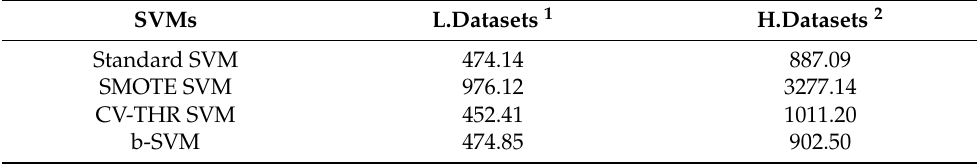
Figure 3. Classification performance (G-mean) of SVMs for simulated high-dimensional datasets. Table 2. Completion time (s) of SVMs for simulated datasets. SVMs L.Datasets 1 H.Datasets